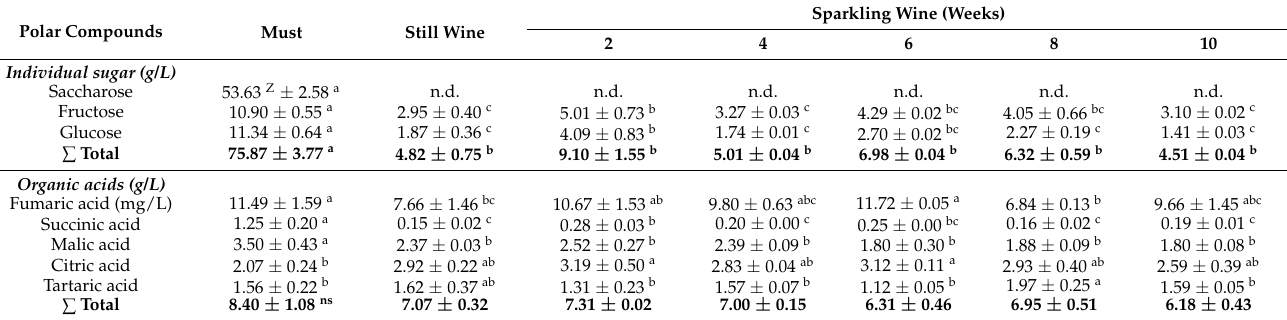
Table 4. Evolution of individual sugars and organic acids of enriched must, still wine, and during the sparkling process of melon-based wine (10